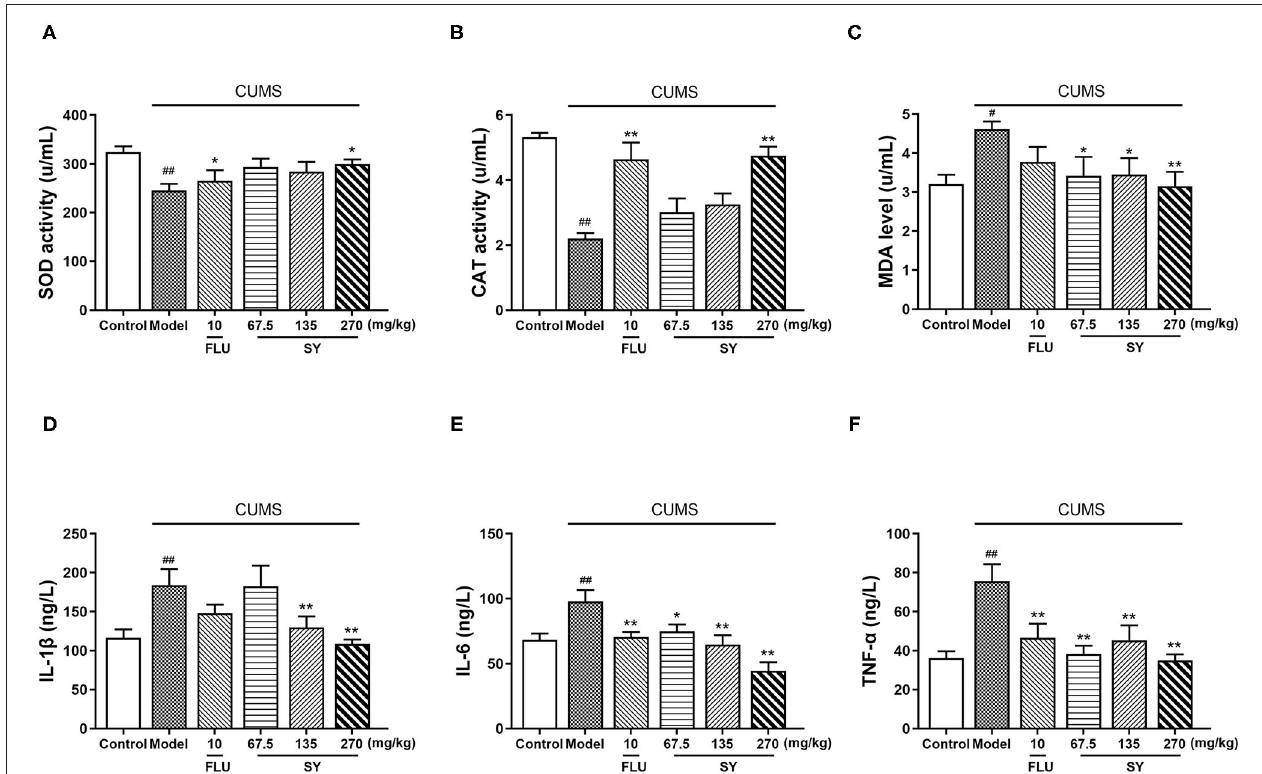
FIGURE 5 | Effects of SY on oxidative stress biomarkers and pro-inflammatory cytokines in CUMS rats. (A) SOD activity. (B) CAT activity (C) MDA level. (D) IL-1 β level. (E) IL-6 level. (F) TNF- α level. Data represent the mean ± S.E.M. ( n = 10 per group). # p < 0.05, ## p < 0.01, vs. the control group; * p < 0.05, ** p < 0.01 vs. the CUMS